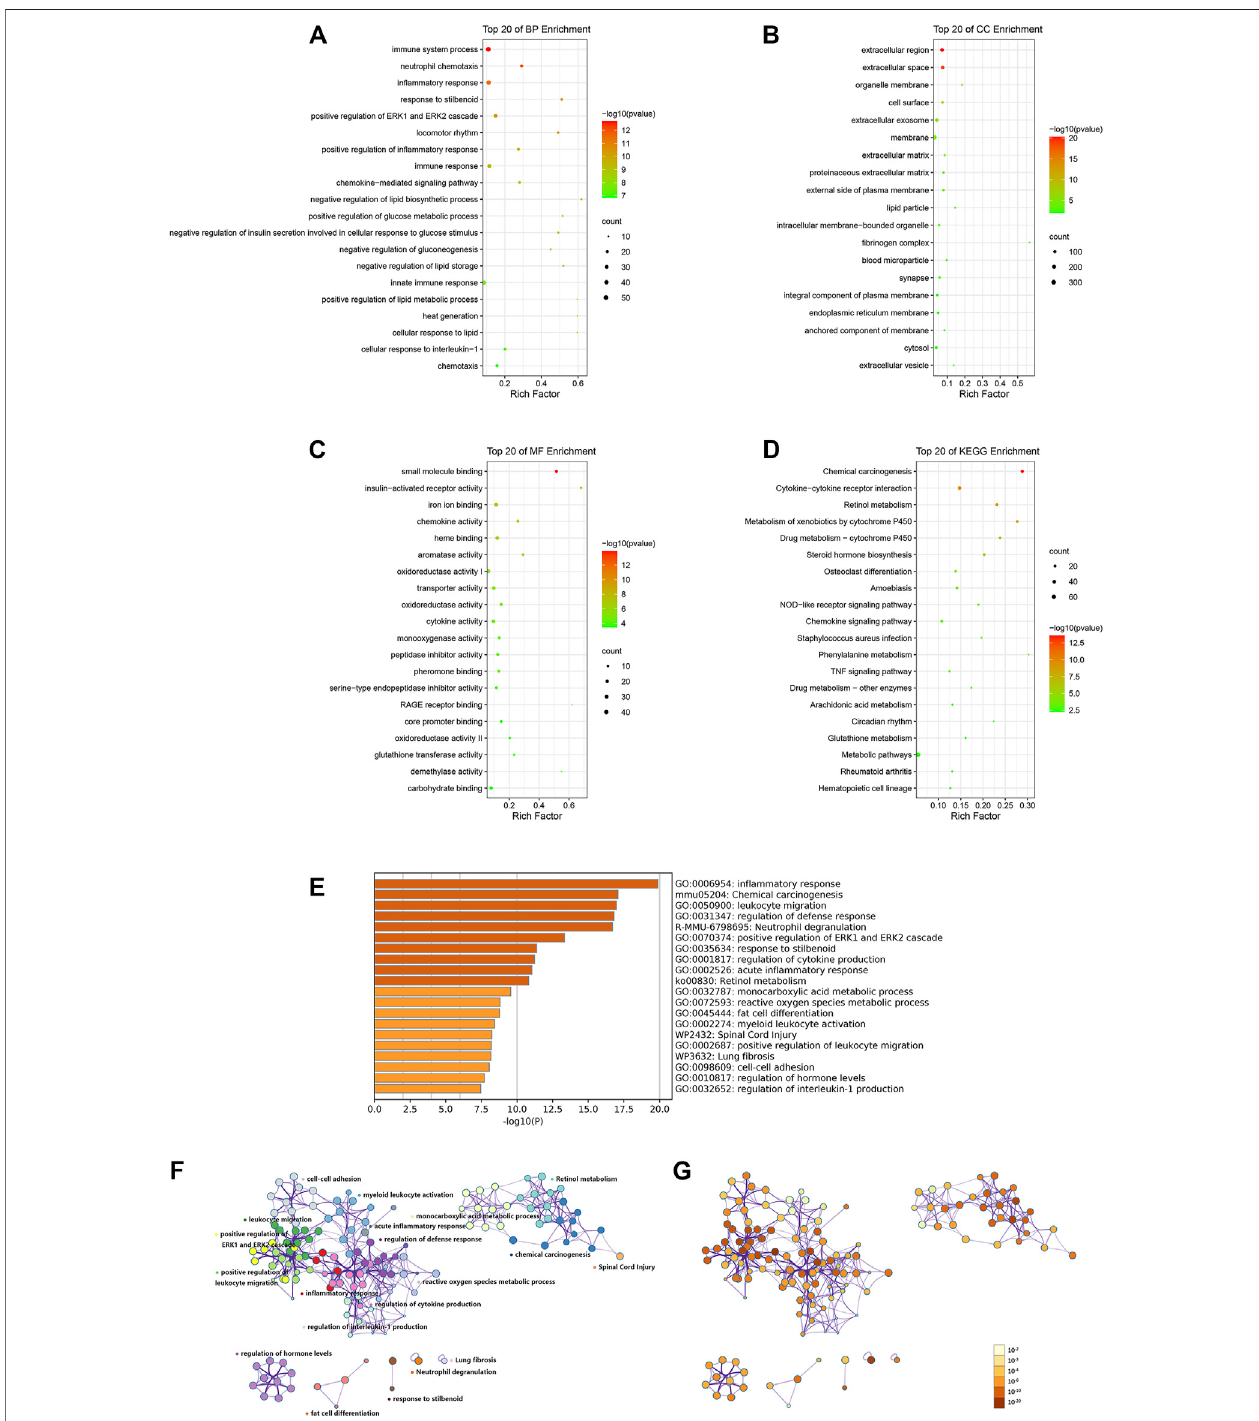
FIGURE3| FunctionalenrichmentanalysesofDEGs via DAVID (A – D) andMetascape (E – G) .VariationsinDEGsassociatedwith (A) biologicalprocess, (B) cellular component, (C) molecularfunction,and (D) KEGGanalysis.RichfactoristheratiooftheDEGnumbertothetotalgenenumberinacertainpathway.Thecolorandsizeof thedots represent therangeofthep-value andthenumber ofDEGsmappedtotheindicated pathways, respectively. (E) Bargraph ofenriched clustersacrossinputted DEGs lists, colored by p-values. Network of enriched terms: (F) colored by cluster ID, where nodes that share the same cluster ID are typically close to each other, (G) colored by p-value, where terms containing more genes tend to have a more signi fi cant p-value. The top 20 signi fi cant enriched pathways are shown.